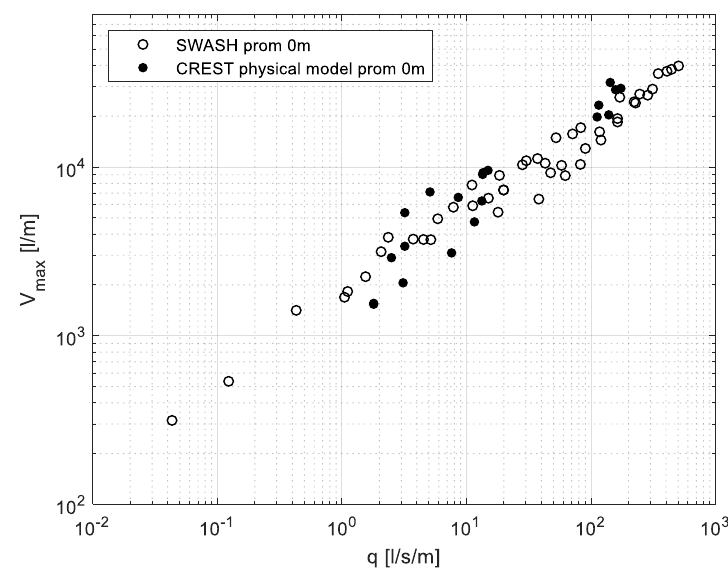
Figure 3. Comparison between SWASH and physical model on q-V max (Average overtopping discharge - maximum individual overtopping volume) for the case of promenade width 0 m.